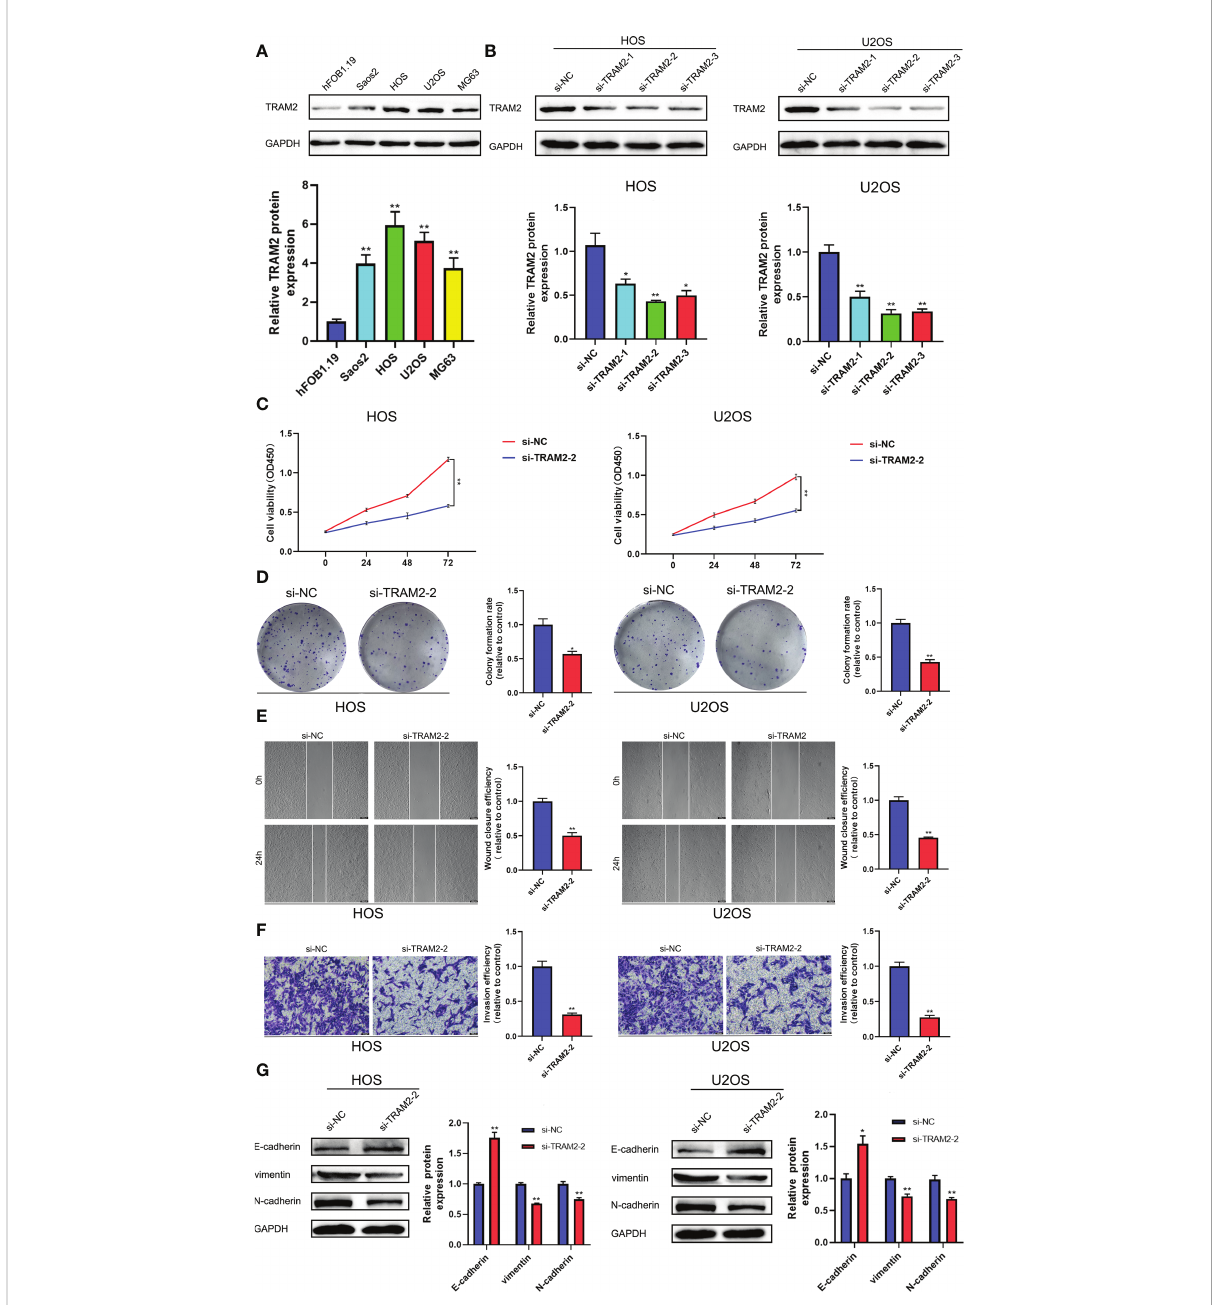
FIGURE 8 TRAM2 suppressed the progression of osteosarcoma in vitro . (A) The protein levels of TRAM2 in Saos2, HOS, U2OS, MG63 cells and normal hFOB1.19 cells. (B) The protein levels of TRAM2 in HOS and U2OS cells after transfection of si-NC, si-TRAM2-1, si-TRAM2-2 and si-TRAM2-3. (C) CCK-8 proliferation assay in HOS and U2OS cells after transfection of si-NC and si-TRAM2-2. (D) Plate cloning assay in HOS and U2OS cells after transfection of si-NC and si-TRAM2-2. (E) Scratch assay in HOS and U2OS cells after transfection of si-NC and si-TRAM2-2. (F) Transwell assay in HOS and U2OS cells after transfection of si-NC and si-TRAM2-2. (G) The protein levels of EMT-related proteins including E-cadherin, vimentin and N-cadherin in HOS and U2OS cells after transfection of si-NC and si-TRAM2-2. All results are presented as mean ± SEM. *P < 0.05, **P <